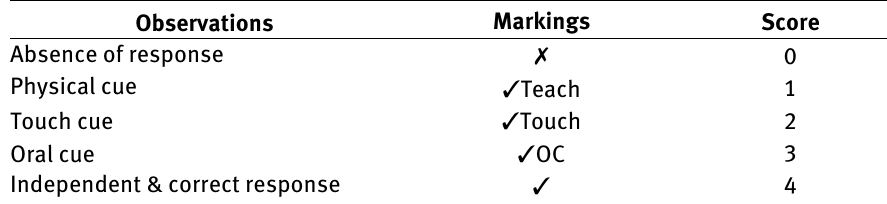
Table 1: Assignment of scores.